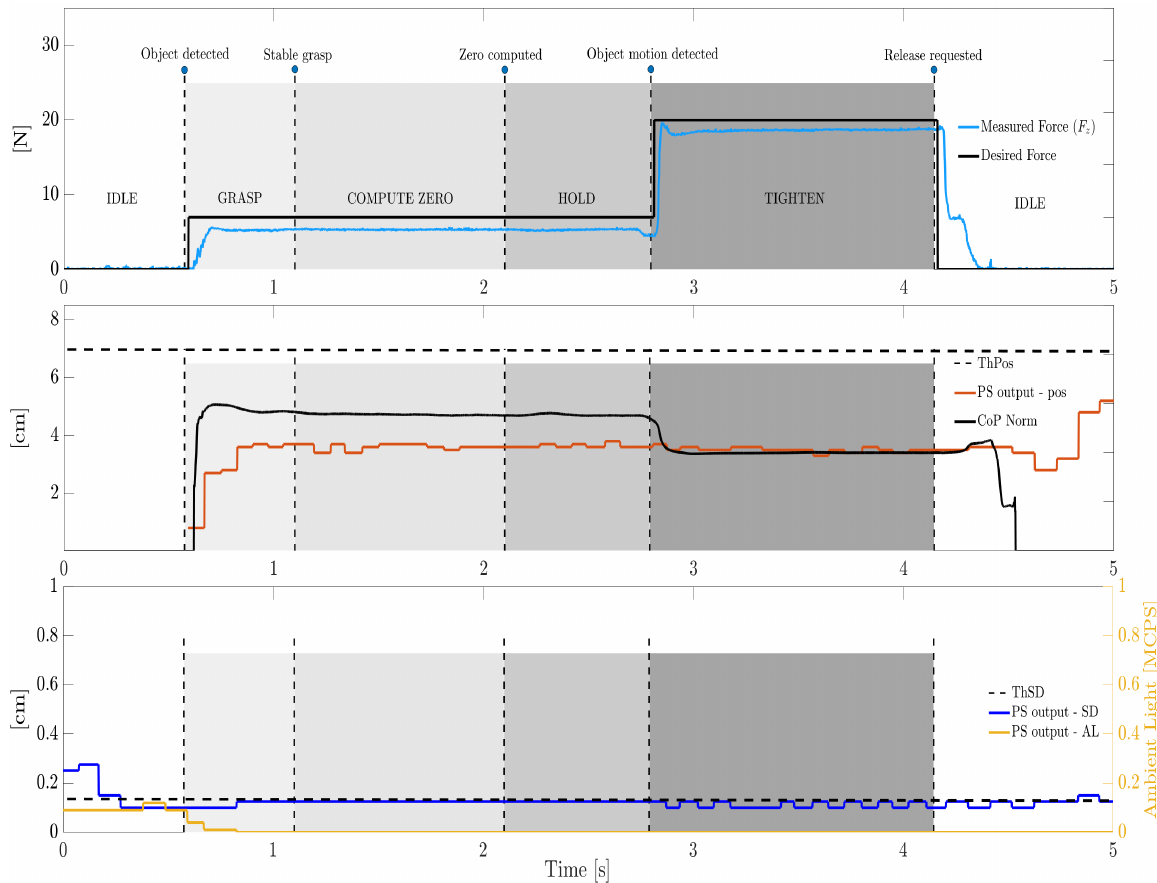
Figure 14. Representative trial on the soft cylinder, rotational slip. The top subplot shows the desired and grasping forces, whereas the mid subplot shows the CoP variation together with the PS distance. The bottom subplot shows the AL and SD characterizing the PS signal. For the sake of clarity, labels of transitions and states are reported only in the top subplot whereas only some of the thresholds are